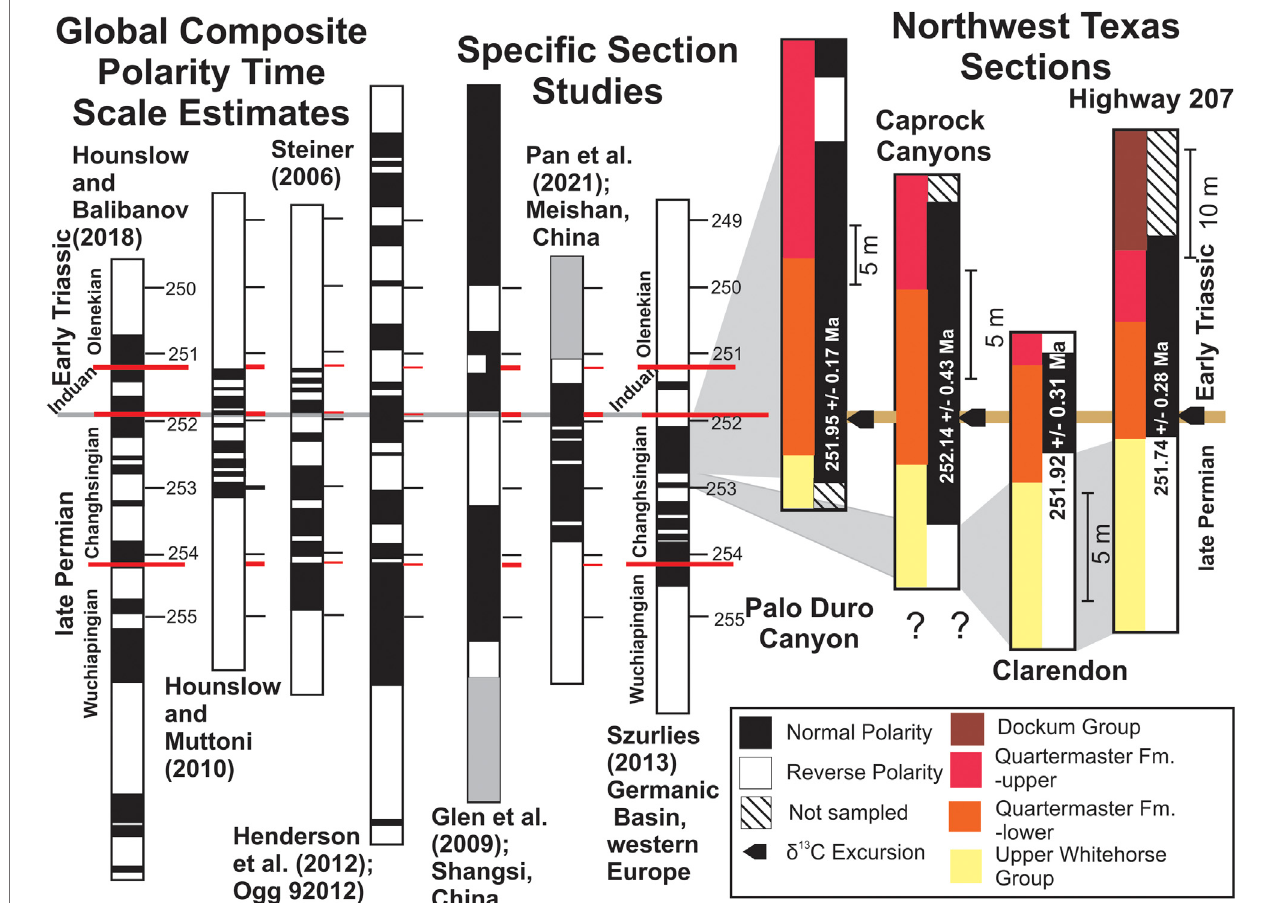
FIGURE 15 | Synthesis of magnetic polarity stratigraphy information from the four stratigraphic sections from northwest Texas discussed in this study, compared with several magnetic polarity time scales for the time interval across the Permian-Triassic boundary, as either proposed global geomagnetic polarity time scales or as results from speci fi c studied sections. The proposed magnetic polarity time scales are scaled to a global chronostratigraphy time scale for the latest Permian/earliest Triassic taken from Yang et al. (2021). For the four stratigraphic sections shown here, we indicate the approximate position, using a heavy tan line, of the stratigraphic interval containing the ash fall (volcanic) deposit(s) that have yielded high-precision U-Pb zircon age determinations (also shown). We also show, via a rectangular arrow, the approximate position of the carbon isotope excursion identi fi ed in three of the sections. In addition, for each of the sections, we show the approximate locations of the intervals of strata belonging to the upper Whitehorse Group, the lower part of the Quartermaster Formation, the upper part of the QuartermasterFormation,andthelowerpartoftheDockumGroup.Threeofthefouroftheglobalcompositemagneticpolaritytimescalesshownwerepublishedbefore revisions to the estimated age of the end-Permian extinction event and the Permian-Triassic boundary (presently ca. 251.9 Ma; see text). This is also the case for the polarity record for the greater Germanic Basin, from Szurlies (2013). We used the numerical ages of the published polarity records (if provided), rather than attempt to adjust the ages of all chron boundaries. Thus, for example, the long normal polarity chron just prior to the Permian-Triassic boundary in Szurlies (2013) would move to a younger time interval and correlates with the long interval of normal polarity documented at the Meishan section (Pan et al., 2021). The polarity time scale of Pan et al. (2021) incorporates the many high precision U-Pb zircon age determinations from ash beds in that section. For the (Hounslow and Balabanov, 2018) global Permian polarity time scale, weusetheir proposed ages provided intheir Table 3 .FortheShangsi section ofGlen et al.(2009),no numerical age information wasprovided inthis study; we used the high-precision U-Pb zircon data in Yuan et al. (2019) from speci fi c numbered beds that contain ash deposits to estimate the ages of magnetozone boundaries.Inlightgray,weshow aninterpretedcorrelation betweenthereversepolaritychron,immediatelypriortothenormal polarity chronconsidered tocontainthe end-Permian extinction event and the Permian-Triassic boundary (Szurlies, 2013), with the reverse polarity magnetozone identi fi ed in three of the four sections shown.